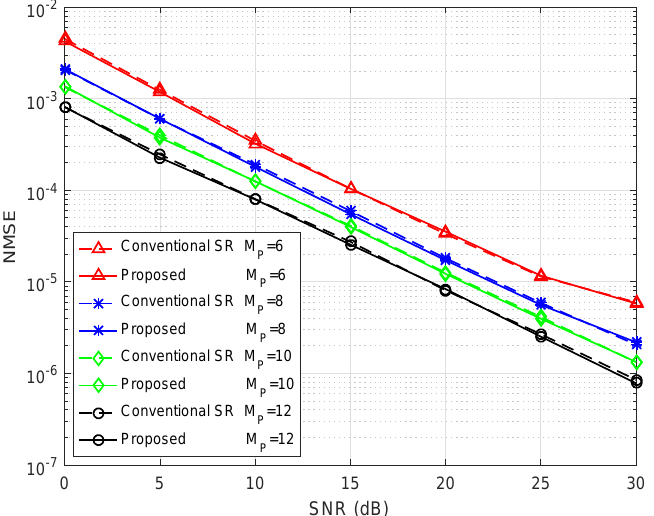
Figure 3. NMSE performance comparison of the proposed and SR